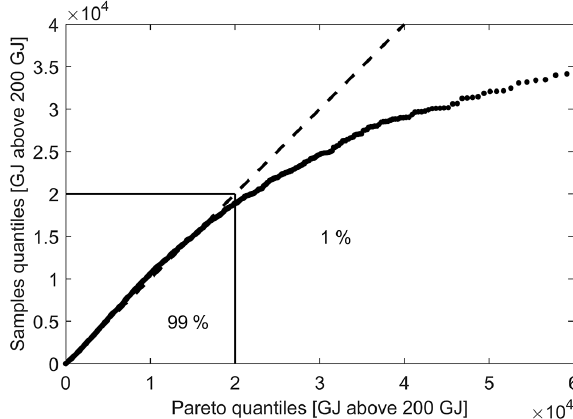
Figure 9. Quantile–quantile plot for the fitted GP distribution. The dashed segment represents the 1:1 line. The square frame at the bottom left that delimits exceedances below 2 × 10 4 GJ contains 99% of the